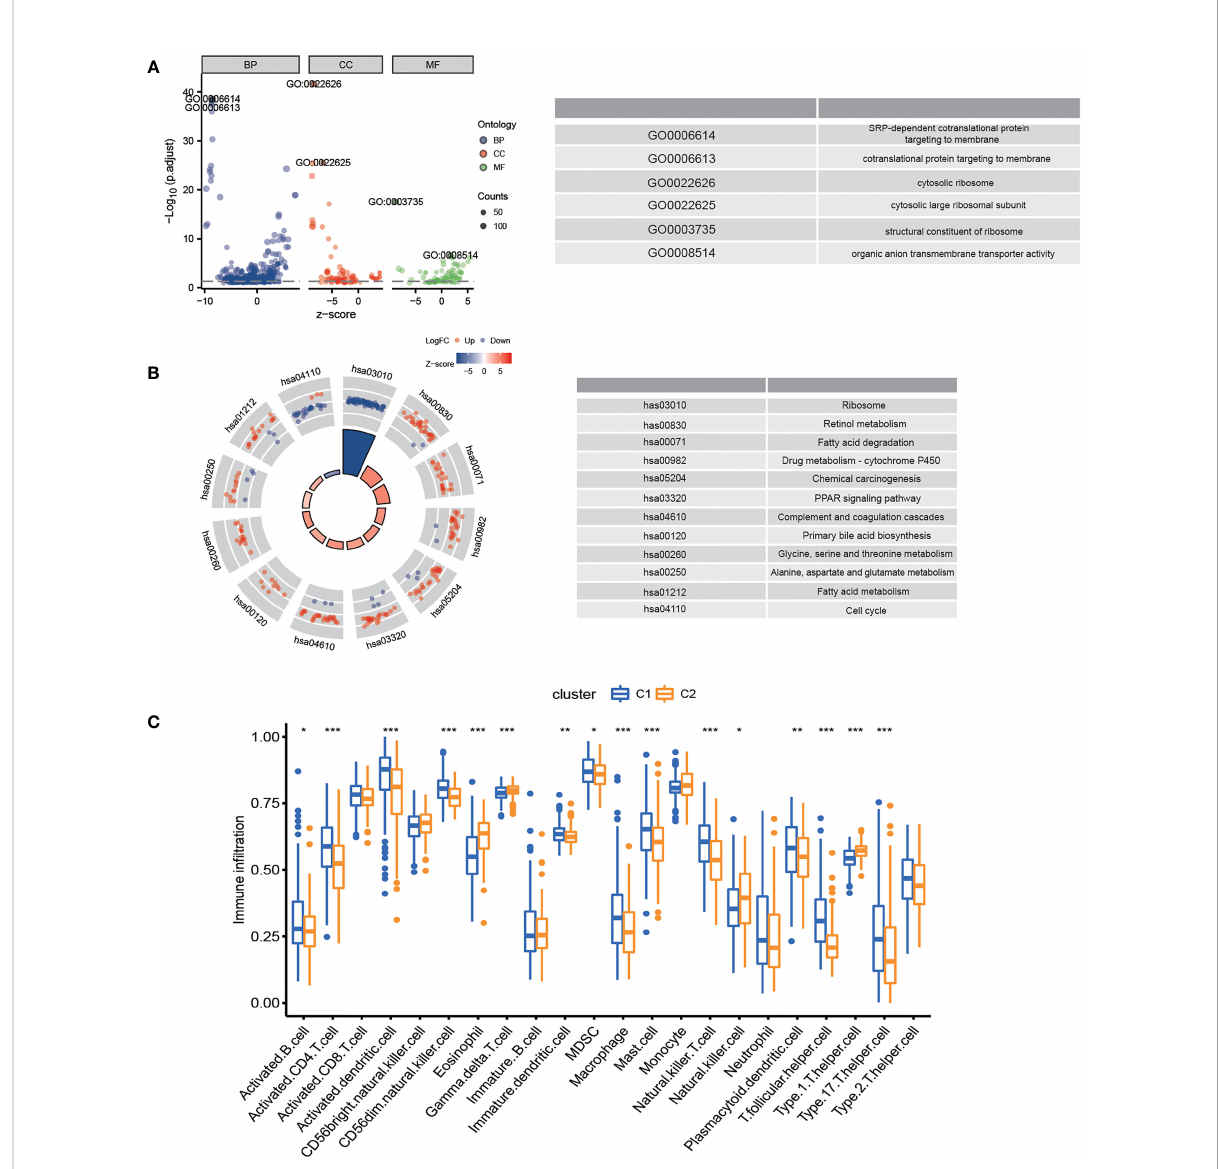
FIGURE 3 Functional Analyses and the Tumor Immune Microenvironment Between FA metabolism-related Subtypes. Potential biological pathways and tumor microenvironment affected by DEGs. GO (A) and KEGG (B) enrichment of DEGs. (C) Comparison of the ssGSEA scores between two subtypes (*p < 0.05, **p < 0.01, ***p <